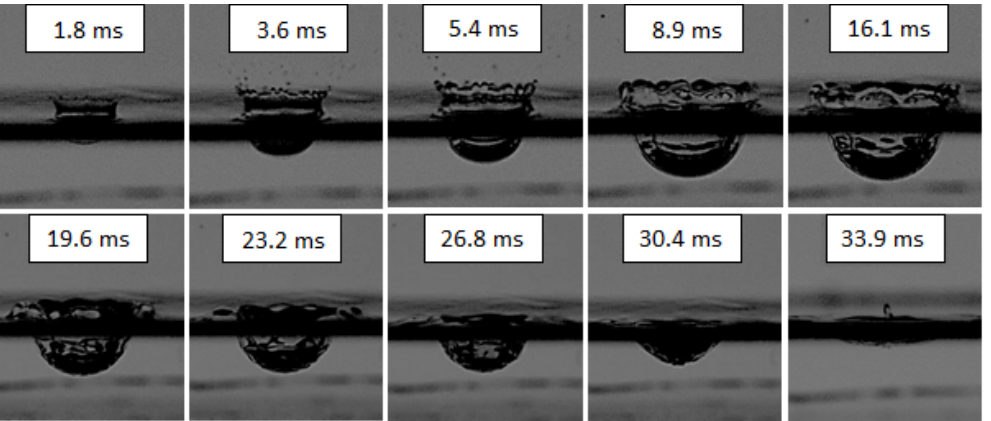
Figure 5. Changes in the shape of the primary forms in the course of their development and disappearance. The values in ms in the pictures refer to the time interval from the moment the drop hit the liquid surface. The dark band visible across the images was caused by the occurrence of a meniscus at the wall of the vessel.